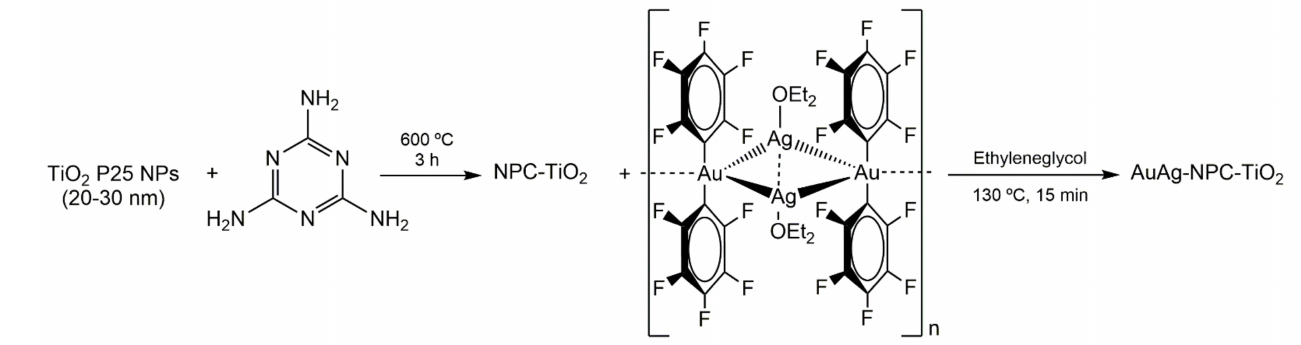
Scheme 1. Synthesis of NPC-TiO 2 nanohybrid 1 and AuAg-NPC-TiO 2 nanohybrids 2–3 by reduction of complex [Au 2 Ag 2 (C 6 F 5 )4(OEt 2 ) 2 ] n in ethylene glycol (EG) at 130 ◦ C. Figure 1 depicts the TEM, HRTEM and HAADF-STEM-EDS micrographs of a sample of NPC-TiO 2 nanohybrid 1 , showing the presence of sheets of NPCs of ca. 100 nm size covering TiO 2 NPs of ca. 15–25 nm size.